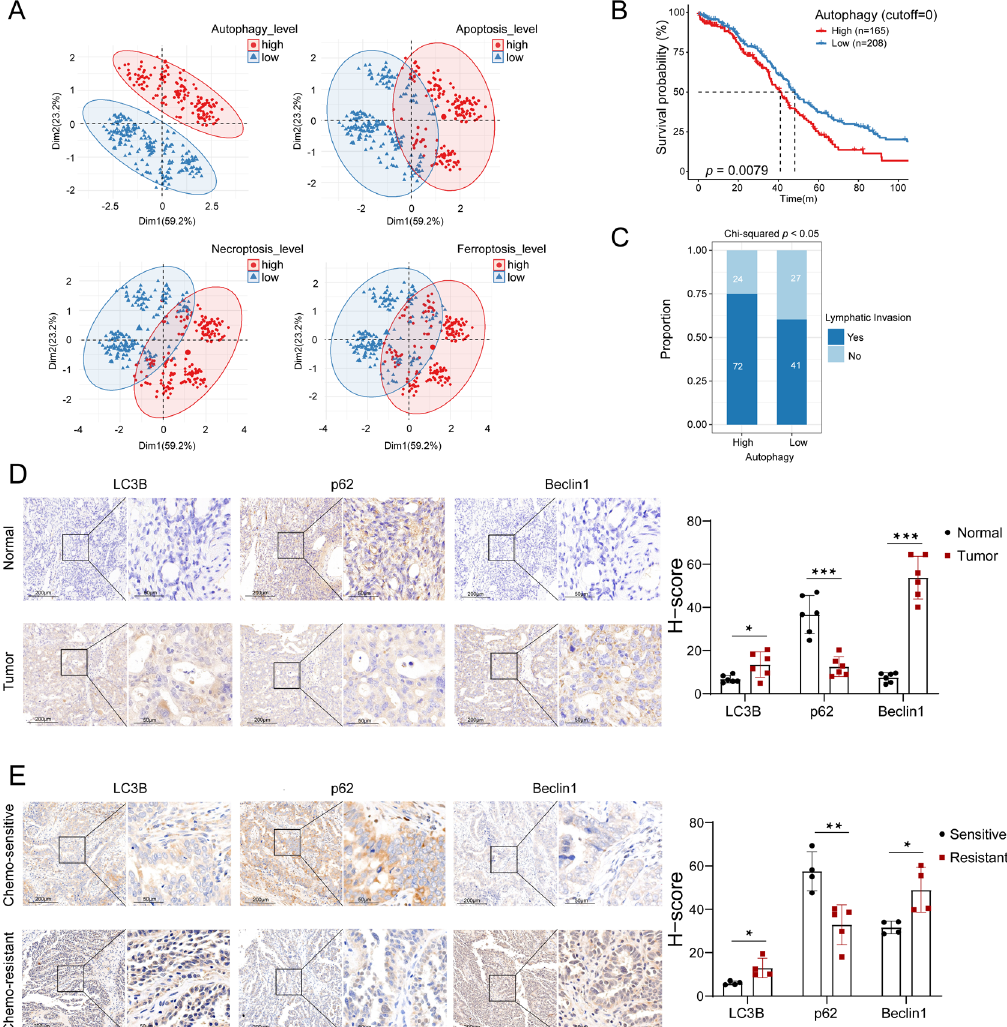
Figure 1. Identification and validation of the correlation between autophagy levels and prognosis of OC patients: ( A ) PCA on the correlation of the OC patients with different levels of autophagy, apoptosis, necroptosis and ferroptosis. ( B ) Kaplan-Meier analysis of the survival outcomes of patients (TCGA) with high and low autophagy levels. ( C ) The proportion of lymphatic metastases in patients with high and low autophagy levels. ( D ) Detection of the expression levels of LC3B, p62 and Beclin1 in OC and normal ovary tissues by IHC assay. ( E ) Detection of the expression levels of LC3B, p62 and Beclin1 in cisplatin-sensitive and cisplatin-resistant OC tissues by IHC assay. (Scale bar, 200 µ m and 50 µ m, * p < 0.05, ** p < 0.01, *** p <